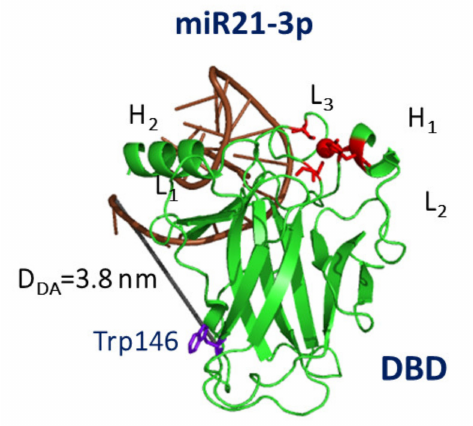
Figure 6. Graphical representation of the best model for the complex between DBD (green) and miR21-3p (brown). The initial structure of DBD was taken from the chain B of 1TUP PDB entry, while that of miR21-3p is the model in Figure 5B. The distance D DA between the center of the aromatic rings of Trp146 and the 5 (cid:48) end of miR21-3p is marked as blue line. miR21-3p binds to DBD at the top in a portion adjacent to the DNA binding region, with the involvement of the DBD L 3 loop, which binds to the minor groove of